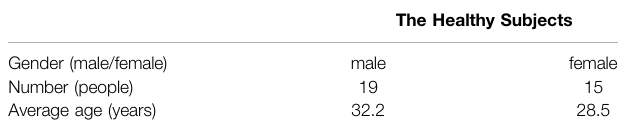
TABLE 1 | The detailed information of the